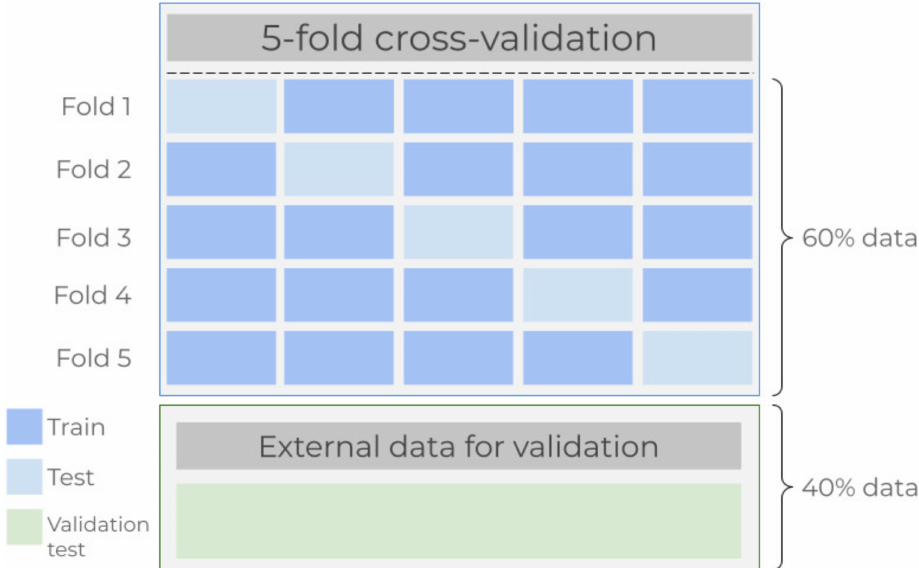
Figure 2. Data partitioning for cross-validation and external validation set.